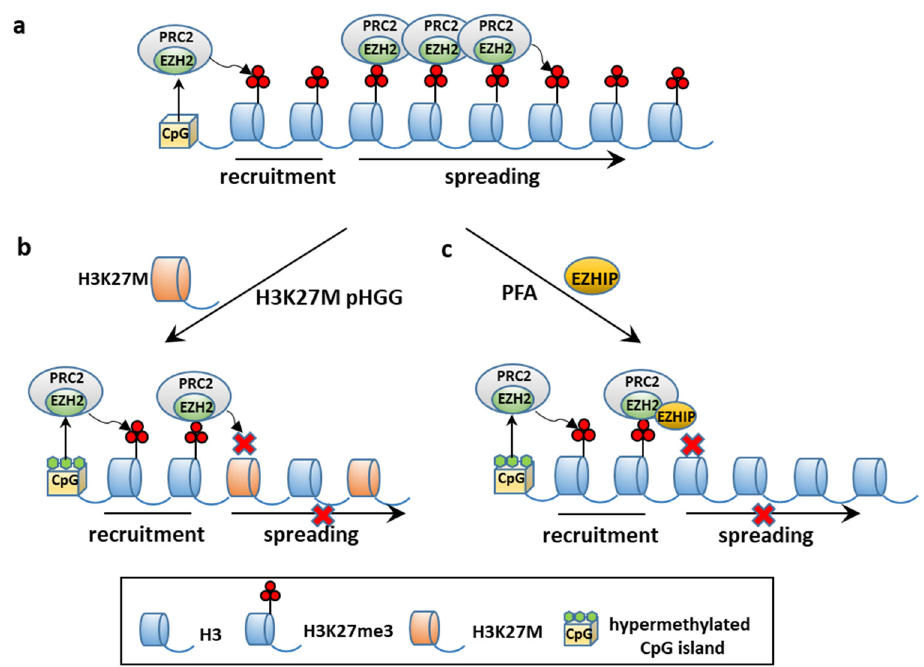
Figure 3. Schematics depicting mechanisms which mediate global loss of H3K27me3 in H3K27M pediatric high-grade glioma (pHGG) and PFA. ( a ) In normal cells, PRC2 is recruited to CpG islands and catalyzes H3K27 trimethylation and spreading of H3K27me3; ( b ) in H3K27M mutant pHGG, PRC2 is recruited at hypermethylated CpG islands, but H3K27M prevents spreading of H3K27Me3; ( c ) in PFA with EZHIP overexpression, PRC2 is recruited to hypermethylated CpG islands, but EZHIP competitively binds to and inhibits EZH2-mediated trimethylation of H3K27 and spreading. Both mechanisms in ( b , c ) determine loss of PRC2-mediated gene repression and transcription of normally silenced genes (Reprinted with permission from Siddhant U. Jain, (2020), Elsevier and Copyright Clearance Center, Licence Number 5200711451432, 2 December